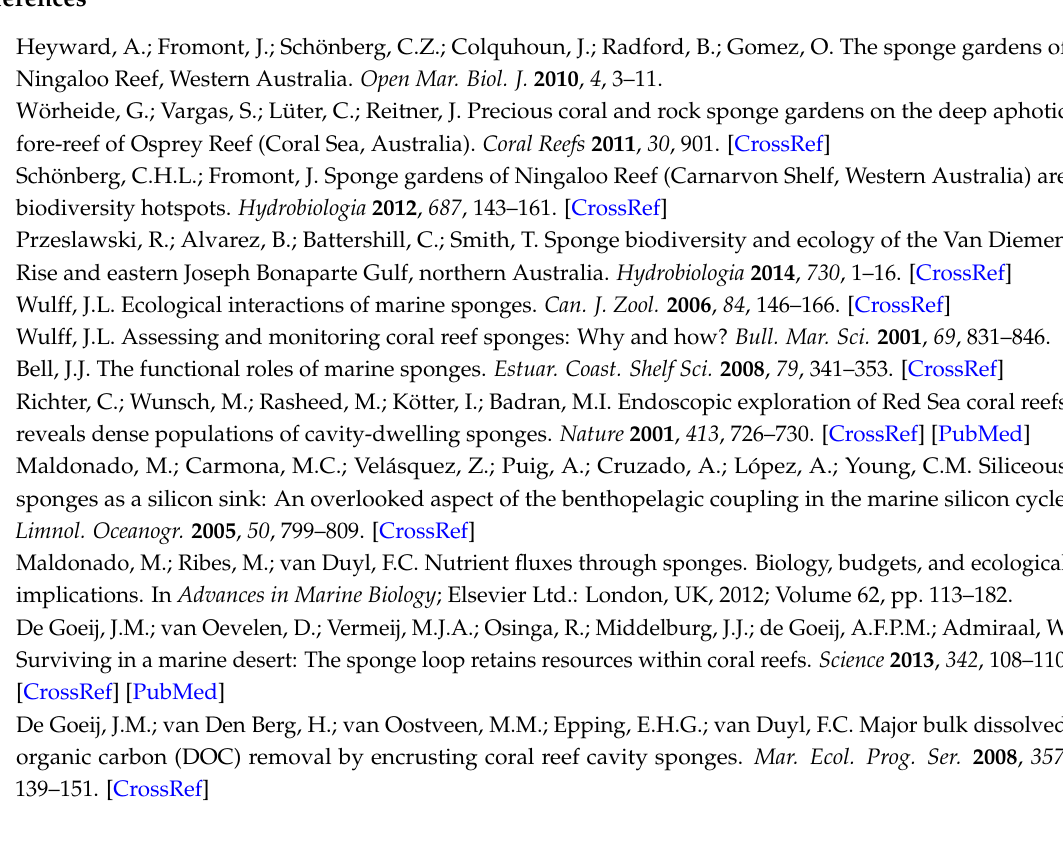
Figure S1: Frequency plots of stations with sponges against number of collection days for all bioregions, Figure S2: Frequency plots of stations with sponges against total number of collection stations for all bioregions, Table S1: Complete described species list and occurrences, Table S2: Summary of collection effort to the final species list, Table S3: Pairwise SIMPER comparison statistics for genera contributing to average dissimilarity between